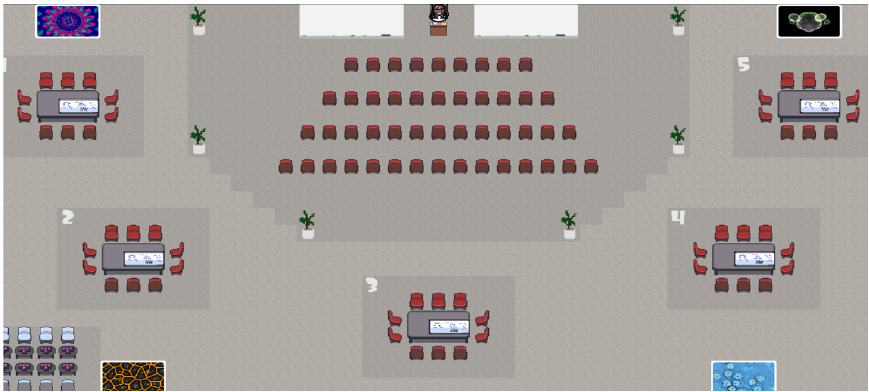
Fig. 1. Lecture hall with five tables with